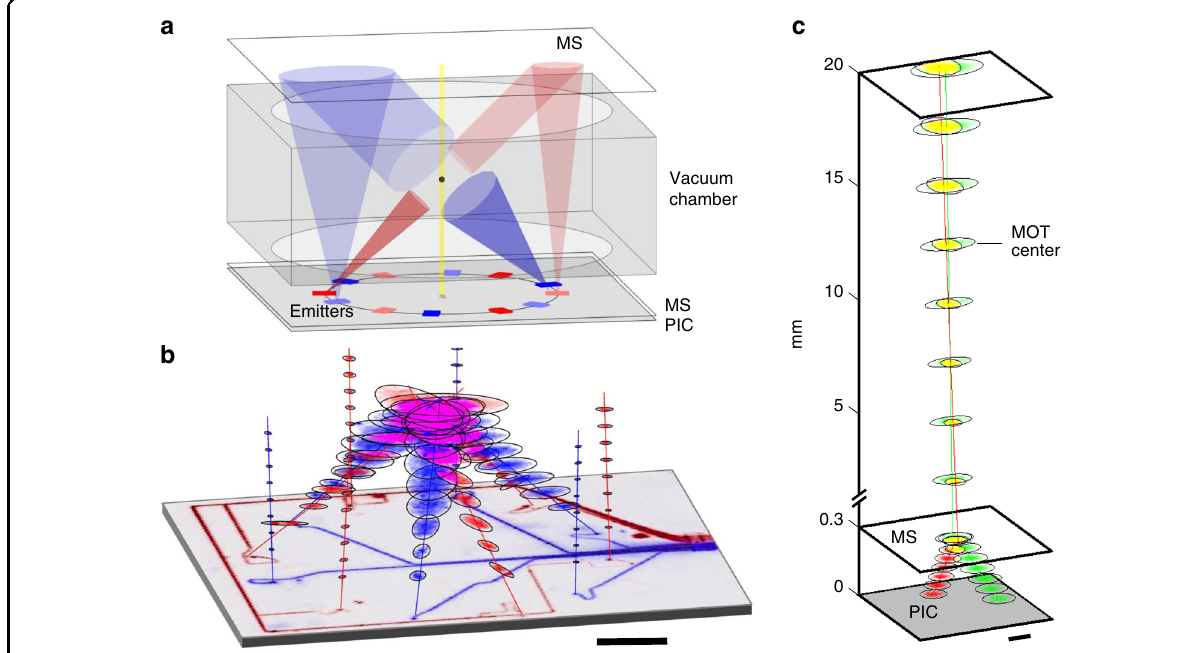
Fig. 1 Sr atomic clock optical beams emitted by integrated photonics. a The photonics geometry as part of the strontium clock, showing the four types of beams including a pair of the red and blue beams at 0° (light color) and 45° (dark color), as well as the collinearly combined lattice and clock beams (yellow). b Measured trajectories of the twelve blue and red MOT beams, overlayed on an image of the PIC. Scale bar is 5 mm. c Measured trajectories of the lattice (green) and clock (red) beams below and above the MS (yellow region depicts the overlap of the two beams). Scale bar is 100